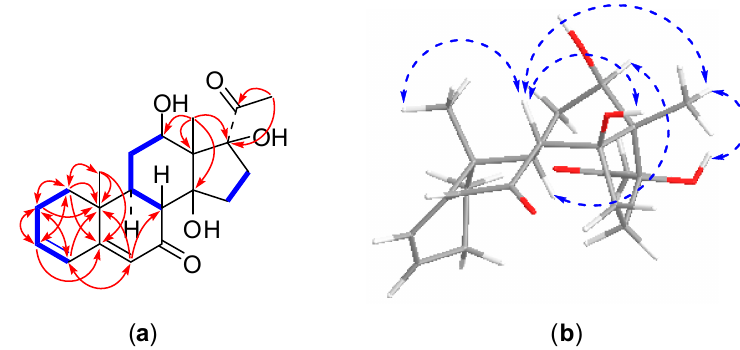
Figure 2. 2D NMR correlations of compound 1 : ( a ) 1 H- 1 H correlations (bold lines) and selected HMBC correlations (arrows); ( b ) selected NOSEY correlations.